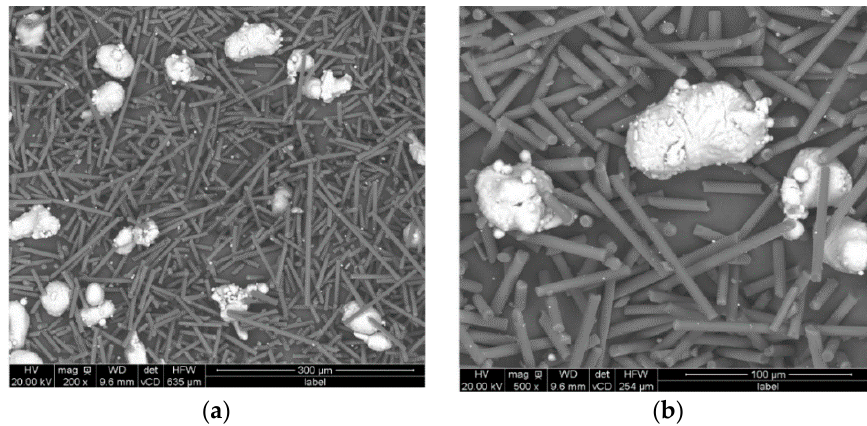
Figure 1. SEM morphology of aluminum powder and carbon fiber powder after ball mixing; ( a ) 200× magnification and ( b ) 500× magnification.